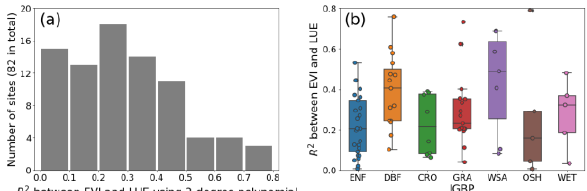
Figure 3. Correlation between EVI and LUE at seasonal scale for all flux tower sites used (a) and for different biomes (b). IGBP in (b) indicates different biome types of flux tower sites: evergreen needle leaf forest (ENF), deciduous broadleaf forest (DBF, including mixed forest sites), cropland (CRO), grassland (GRA), woody savanna (WSA, including savanna), open shrubland and wetland